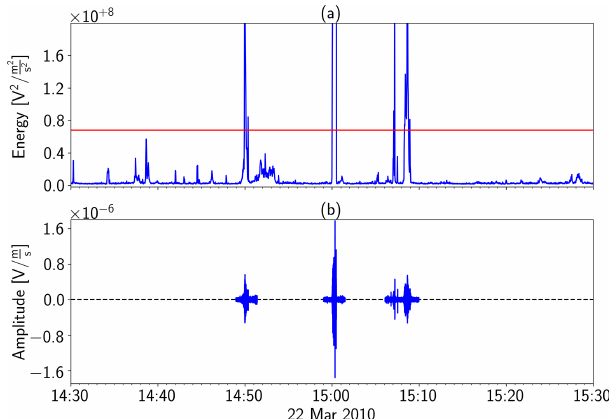
Figure 2. Example of the pre-processing: (a) the mean energy val- ues of each window shown as the blue line and the threshold value indicated by the red line; (b) the remaining data cut by the pre- processing